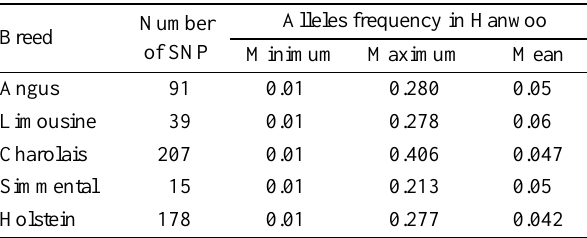
Table 2. The number of private SNPs found in Hanwoo compared to each breed genotyped by the Bovine SNP50K assay Alleles frequency in Hanwoo Number Breed of SNP